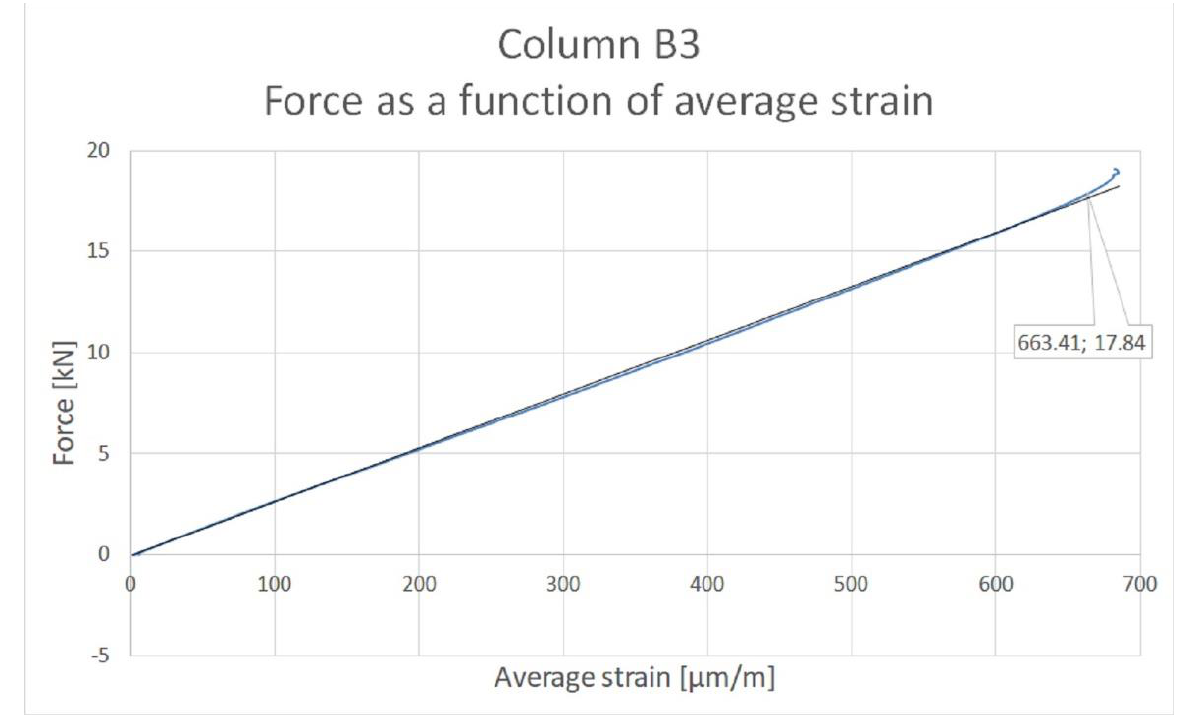
Figure 7. Determination of critical force value for column B3.